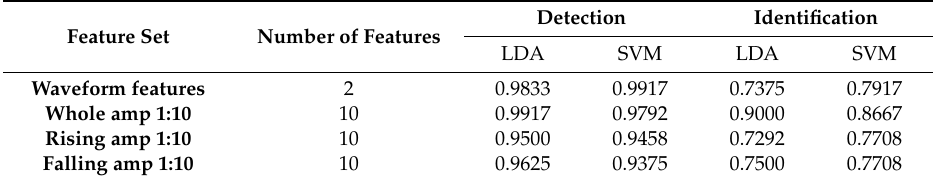
Table 1. Classification accuracies on two-class (detection) and twelve-class (identification) tasks using leave-one-out cross-validated LDA and SVM classifiers and four feature sets.